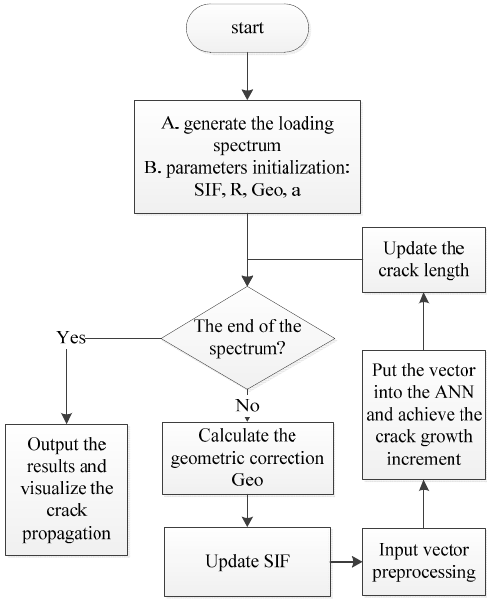
Figure 12. Flow chart of programing the predicting algorithm.